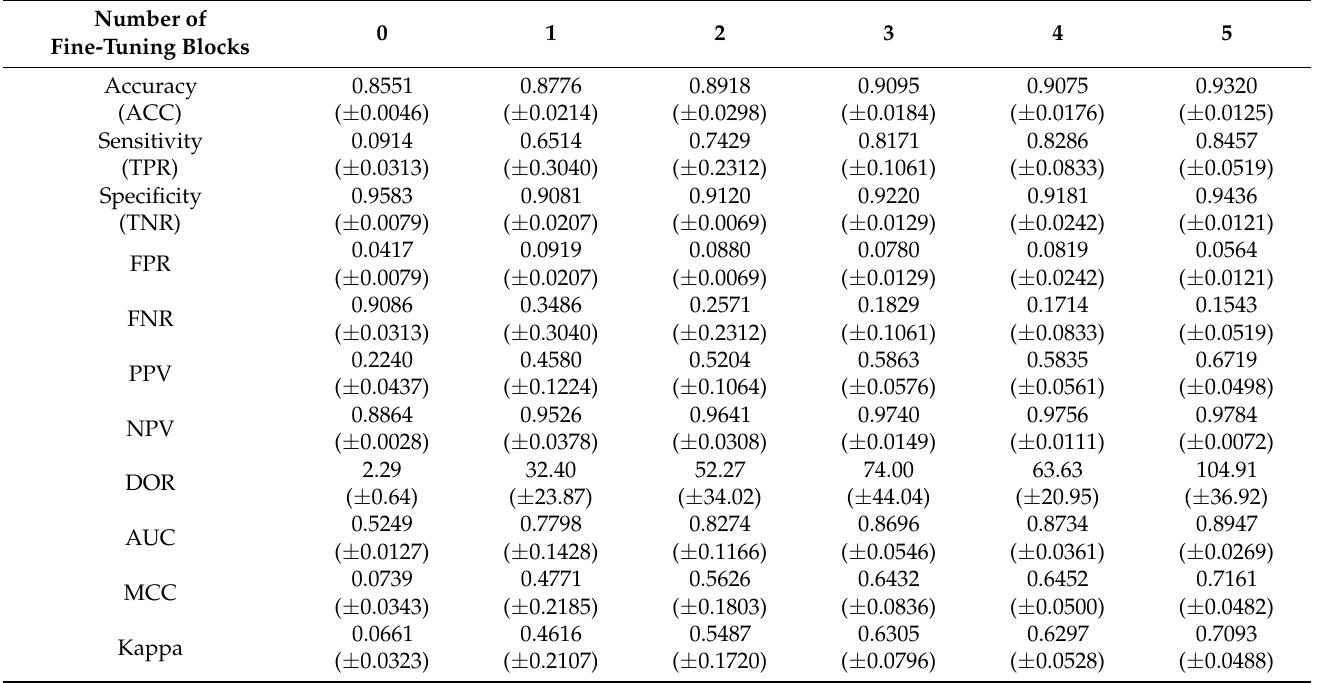
Table 1. Performance metrics of experimental groups of this